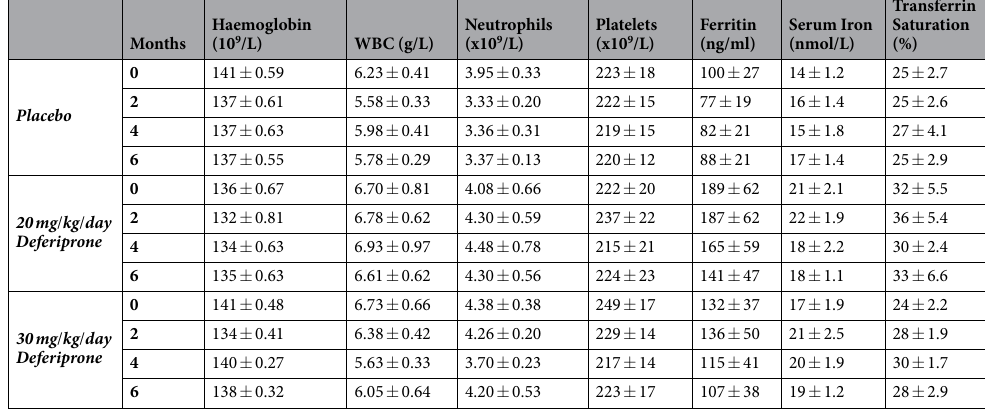
Table 3. Haematological and iron status measurements expressed as medians + / − SEM of Parkinson’s disease patients receiving 20 mg/kg/day (n = 6) or 30 (n = 5) mg/kg/day deferiprone or placebo (n = 8) for 6 months. WBC - white blood cells.